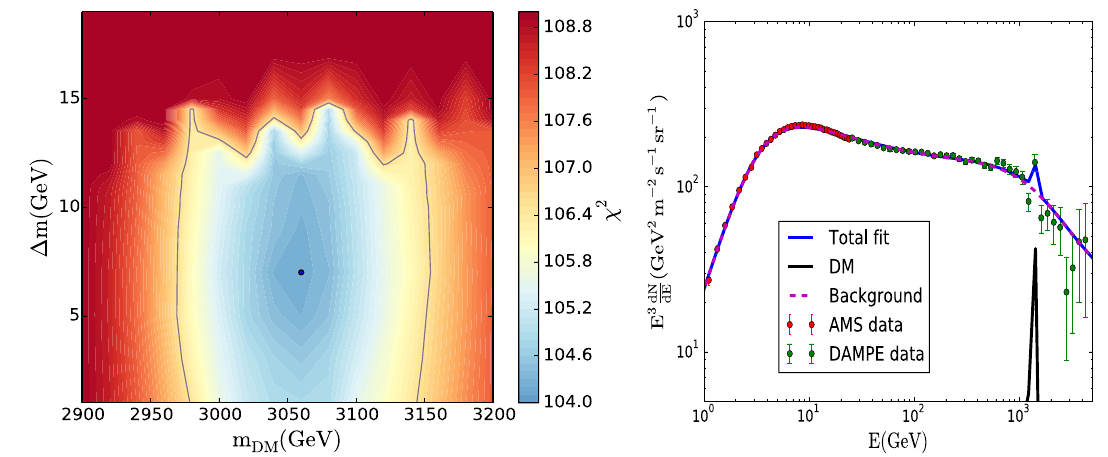
Fig. 1 Fitting the e + e − spectrum generated by the process χχ → Z (cid:3) Z (cid:3) with Z (cid:3) → e + e − ,μ + μ − to the AMS-02 and DAMPE data with the background parameterization taken from [8]. Left panel: χ 2 map projected on (cid:3) m − m χ plane with (cid:3) m ≡ m χ − m Z (cid:3) and the color bar